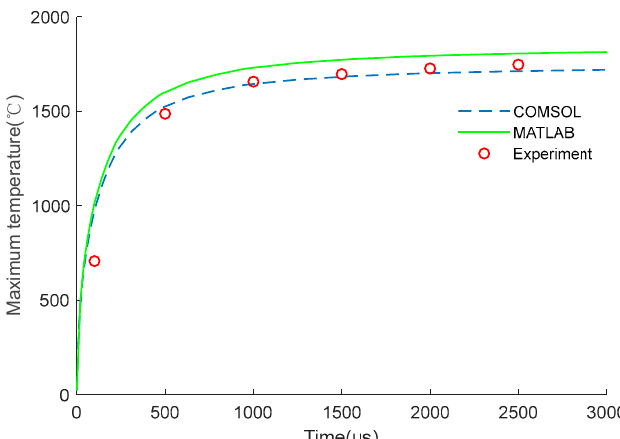
Figure 7. Simulation and experimental results under constant voltage excitation.